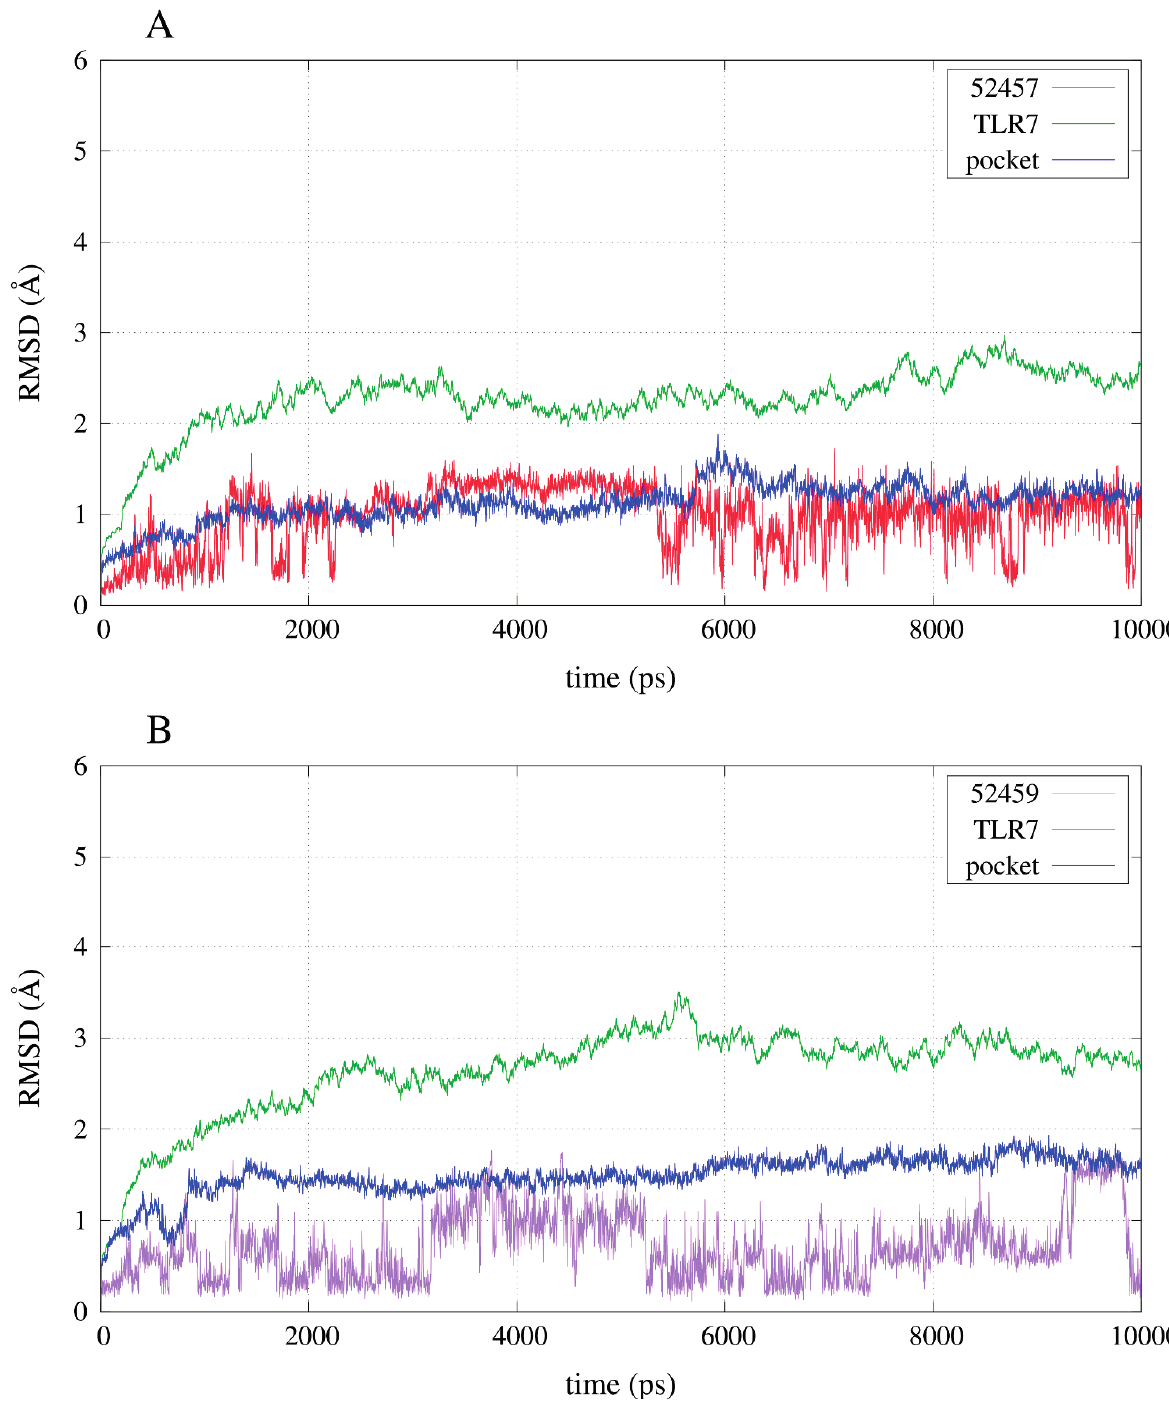
Figure 6. RMSD trends for backbone, binding pocket and two selected inactive compounds. ( A ) RMSD for 52457 in complex with TLR7; ( B ) RMSD for 52459 in complex with